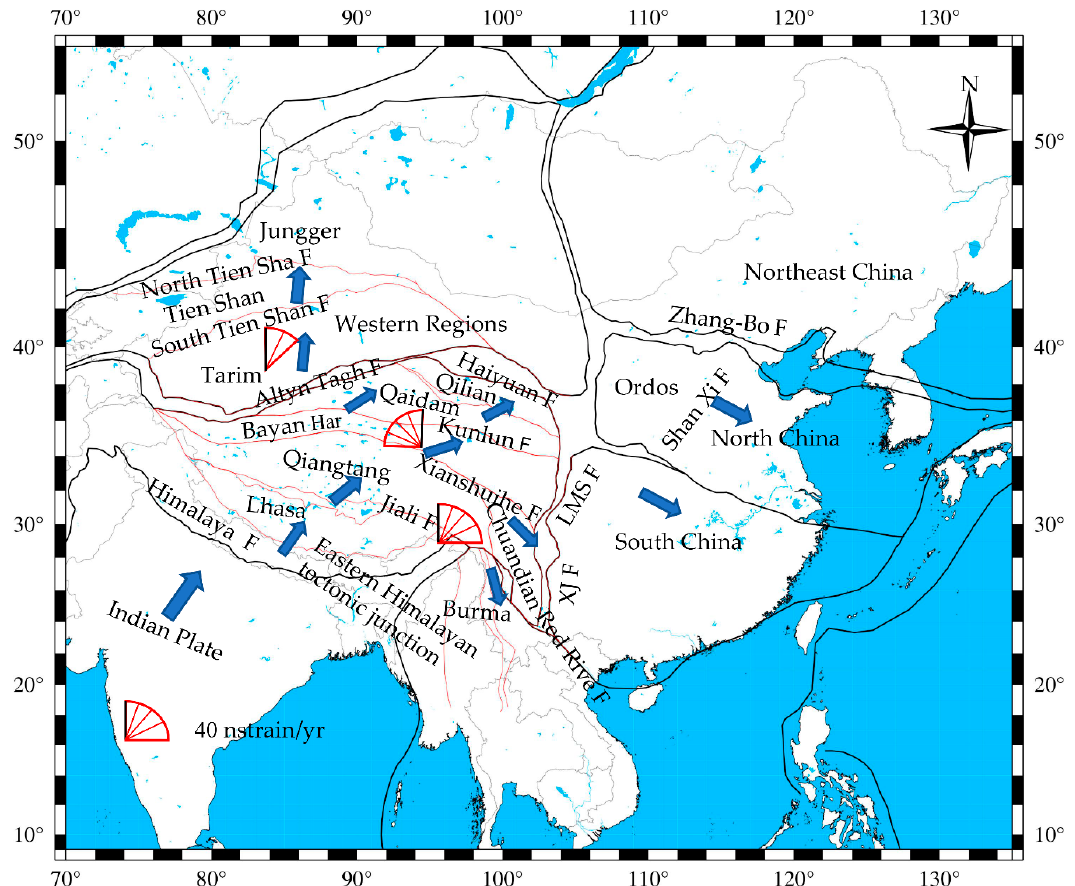
Figure 6. Block motion model. Blue arrows indicate motion directions. Red fan shapes denote block rotation rates. The thick black line is the boundary line of the first active block; The red line is part of the boundary line of the second active block; Chuandian represents Sichuan-Yunnan; XJ F represents Xiaojiang fault; LMS F represents Longmen Shan fault.